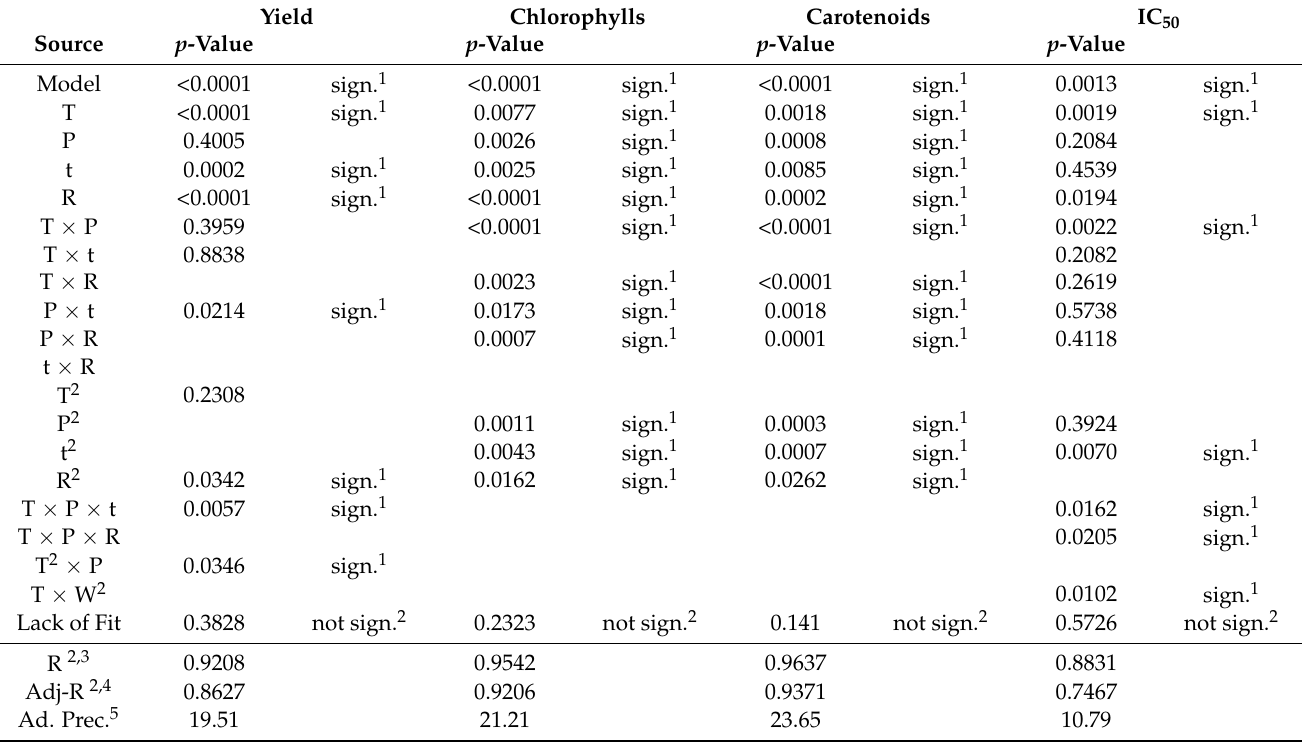
Table A1. The ANOVA results and statistical measures of models’